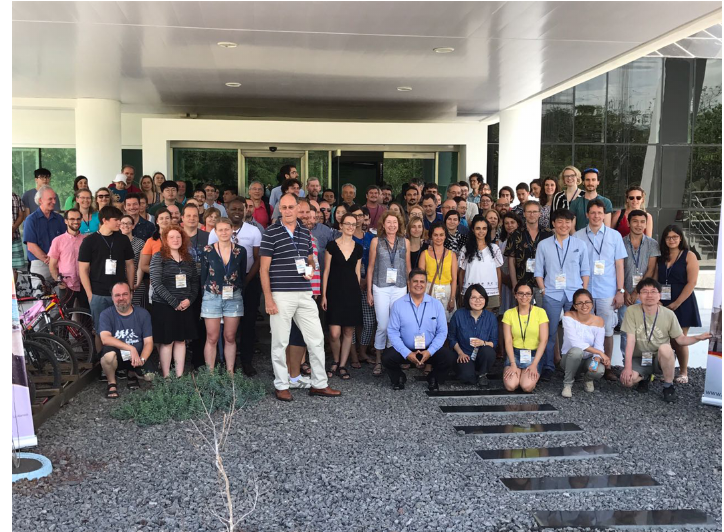
Figure 1. Conference photograph showing participants outside of the conference venue, the CIER (Centro de Informacion de Energia Renovable)